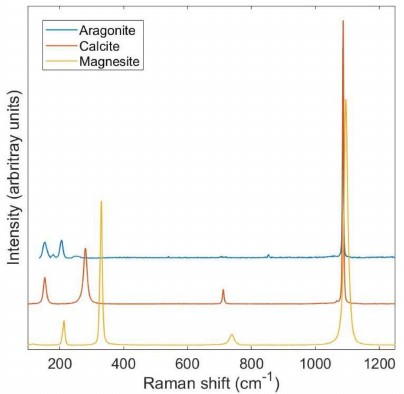
Figure 1. Example Raman spectra from The RRUFF TM Project database of the minerals aragonite (R080142), calcite (R040010), and magnesite (R040114). These spectra illustrate the change of the number, position, and width of the bands that occur in the Raman spectra due to changes in structure (aragonite-calcite) and chemistry